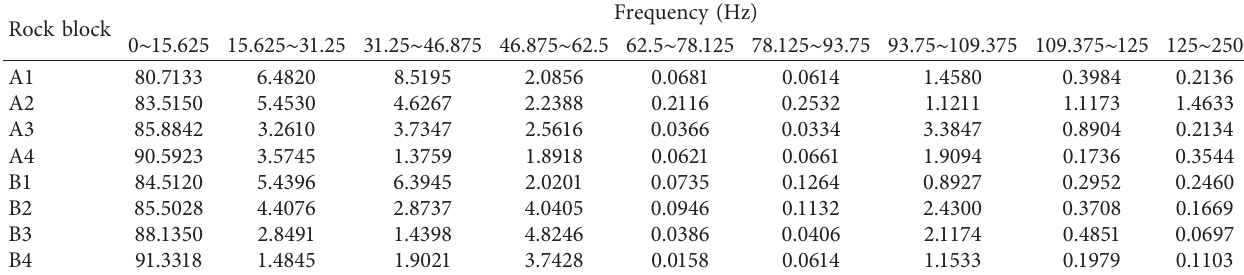
Table 5: The energy proportion of frequency band of each monitoring block in Model